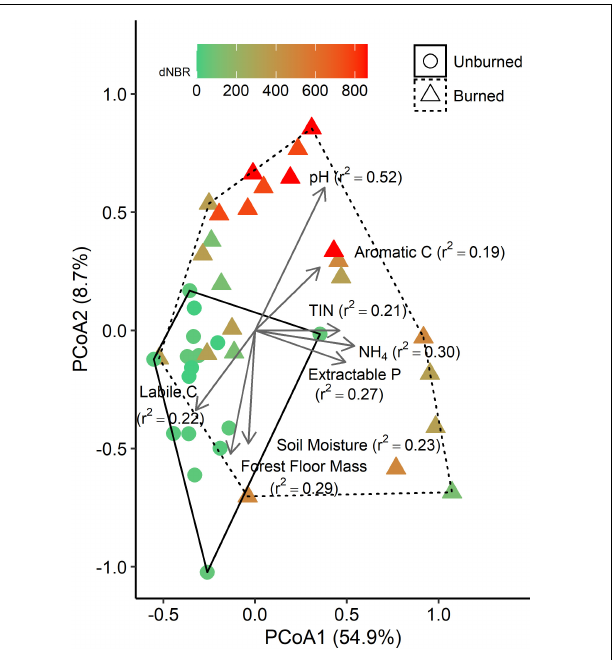
FIGURE 3 | Principle coordinates analysis (PCoA) plots based on a weighted UniFrac distance matrix of bacterial communities in mineral soils (0–5 cm). Each point represents the bacterial community from a single subplot. Vectors represent variables that are significantly correlated with one of the PCoA axes, and vector lengths are scaled based on r 2 values. Solid and dashed hulls depict the ordination space that encompasses all burned and unburned samples,